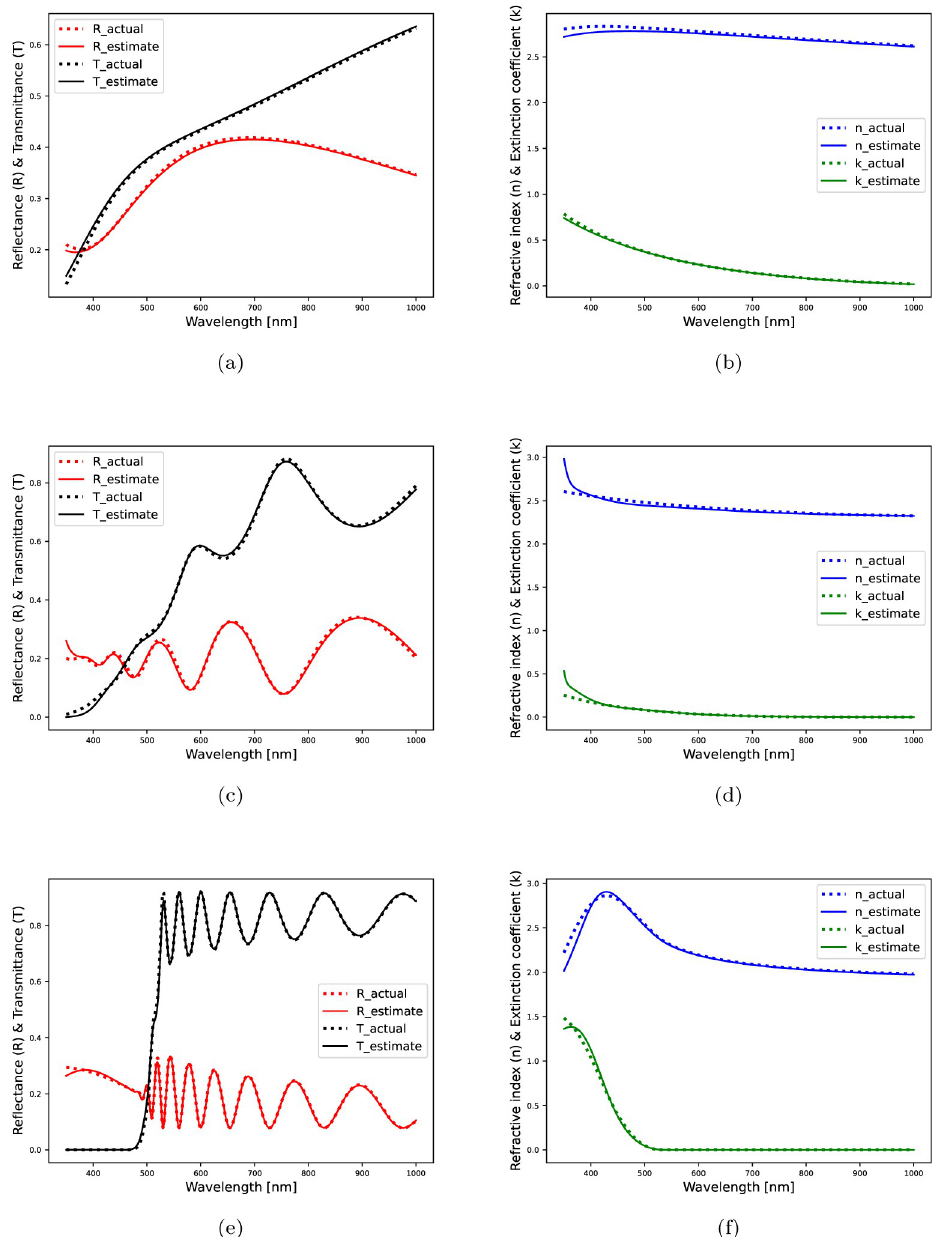
Fig 3. Inverse solutions obtained using the synthetic spectral data of metal-oxide films: (a) Actual and estimated spectra with optimized TLO ensemble; total estimation loss = 0.0260, (b) Actual and estimated optical constants with TLO; actual and estimated thickness = 60.0, 60.26 nm , (c) Actual and estimated spectra with optimized GO ensemble; total estimation loss = 0.1011, (d) Actual and estimated optical constants with GO; actual and estimated thickness = 477, 479.71 nm , (e) Actual and estimated spectra with optimized TLO ensemble; total estimation loss = 0.0493, (f) Actual and estimated optical constants with TLO; actual and estimated thickness = 1230, 1233.54 nm . wavelength range of 350 − 1000 nm. Fig 7(c) help visualizing that GO fits the spectra better than TLO in the wavelength range of 350 − 500 nm, with an appropriate broadening [46]. These results justify that the model-based optimization with CMAES can produce accurate d , n ( λ ), k ( λ ) estimates using real data with experimental uncertainty.